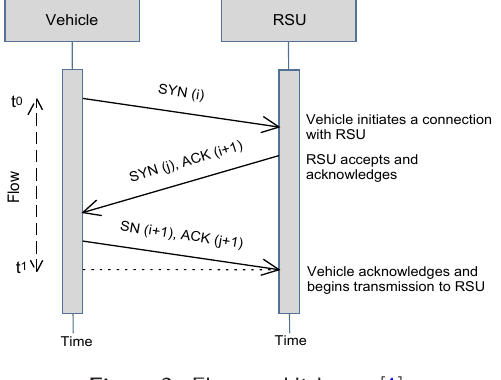
Figure 3. Flow establishment [1].